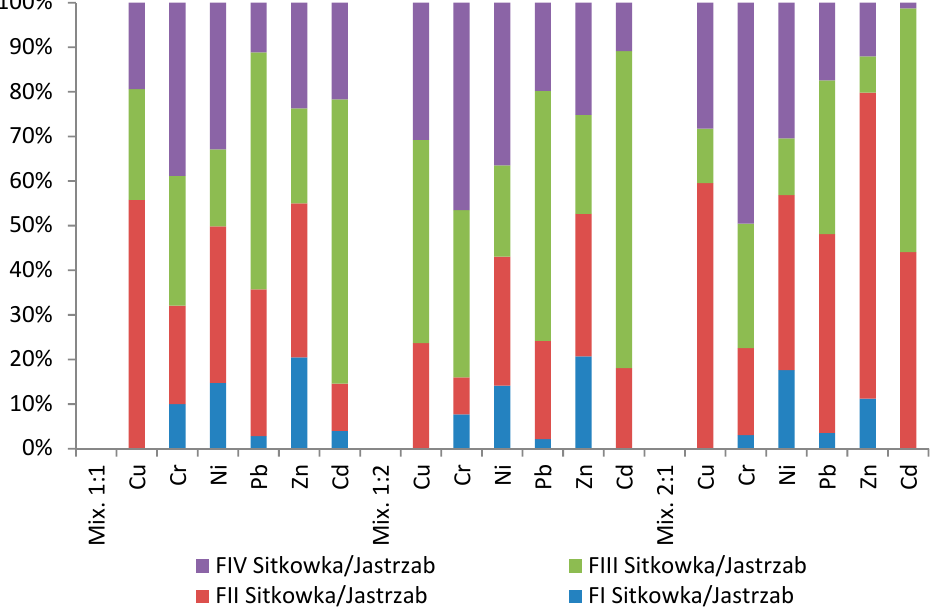
Figure 8. Percentage contents of heavy metals for particular fractions in Sitkowka–Jastrzab sludge– soil mixtures.